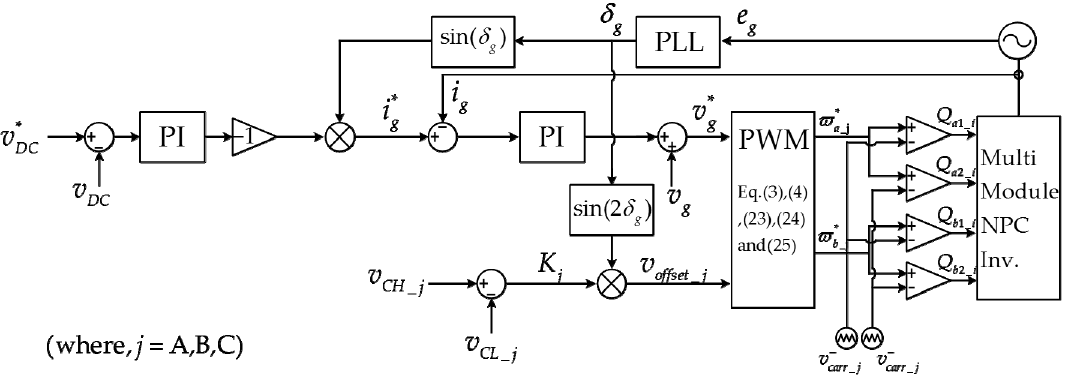
Figure 3. Proposed multi-level NPC inverter control block with offset voltage generator.